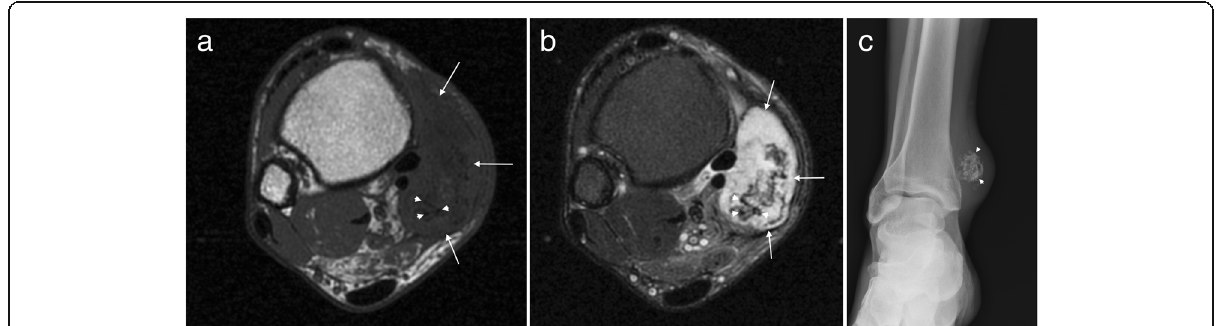
Fig. 6 Soft tissue chondroma. Axial T1W ( a ) and T2FS ( b ) images of the ankle with a large well-defined posteromedial mass (arrows) which appears T1 hypointense and T2 hyperintense with internal low signal chondroid foci (arrowheads). The chondroid matrix is readily appreciated on the corresponding radiograph ( c